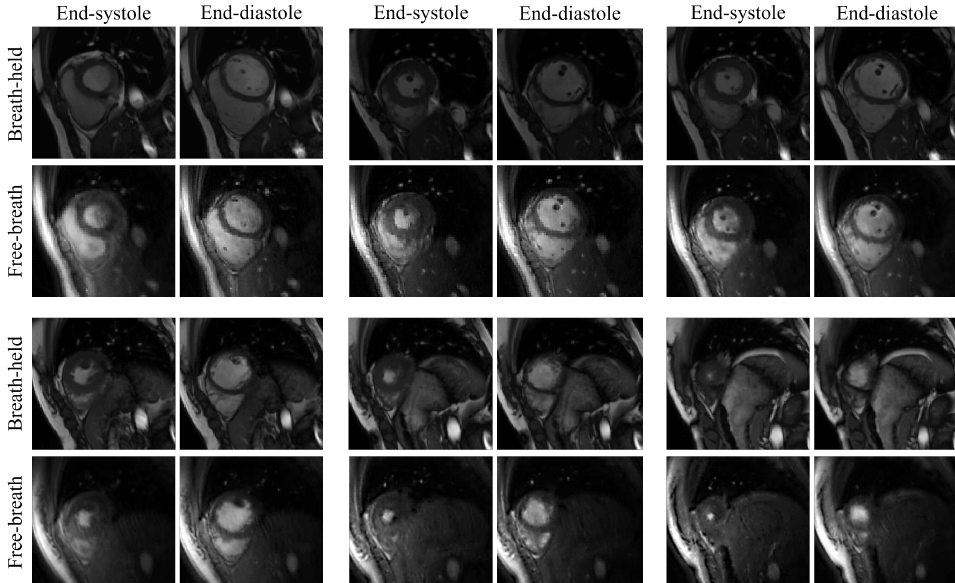
Figure 4. Visual comparison of the reconstructed free-breathing images and the fully-sampled breath- hold images. End-systolic and end-diastolic phases from six slices are shown in the figure. The six slices are from Subject #4. We note that the free-breathing images are acquired using the GRE sequence and the fully-sampled breath-hold images are acquired using the bSSFP sequence. This results in different contrast between the two types of the images.